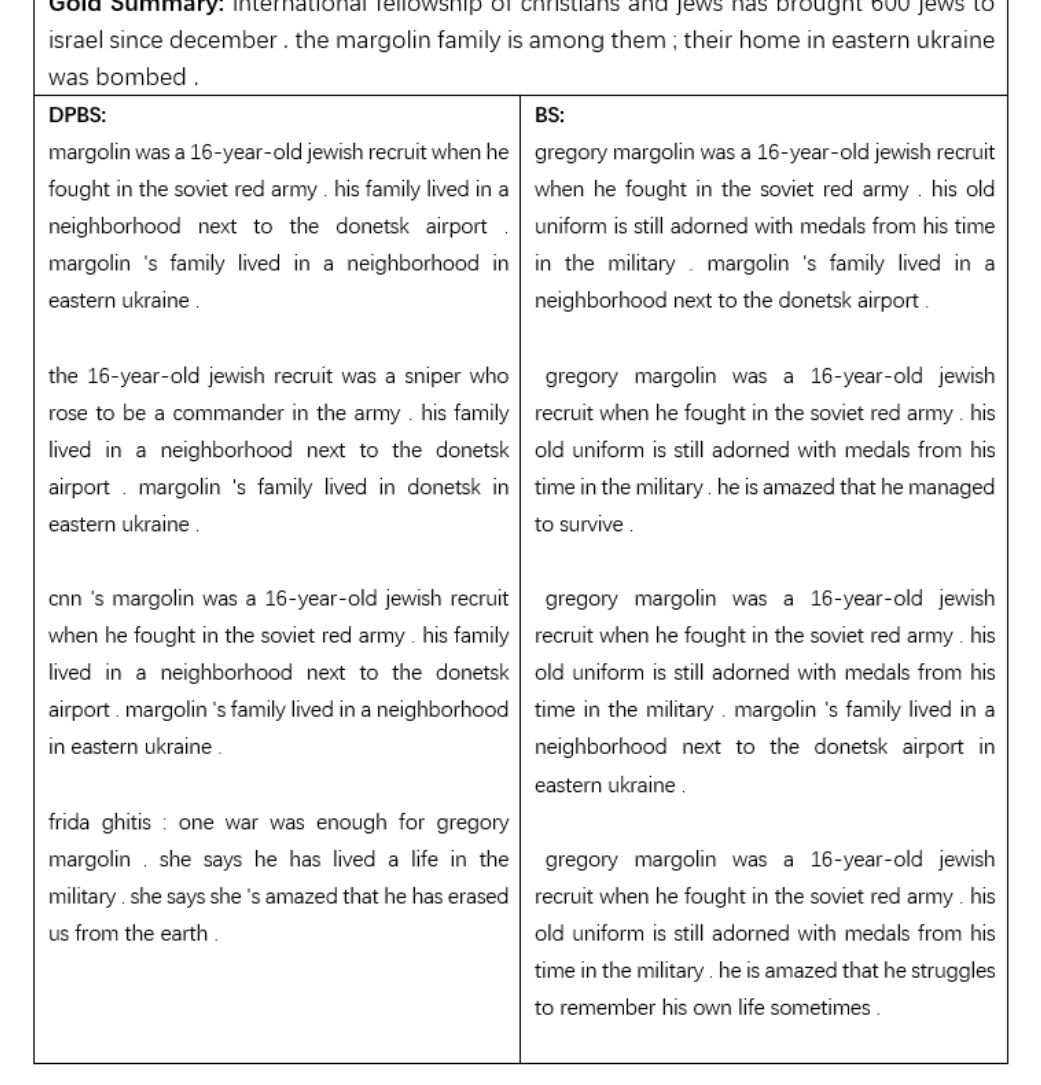
Figure 4. Example from the CNN/Daily Mail test dataset showing the outputs generated by both DBPS and standard Beam Search